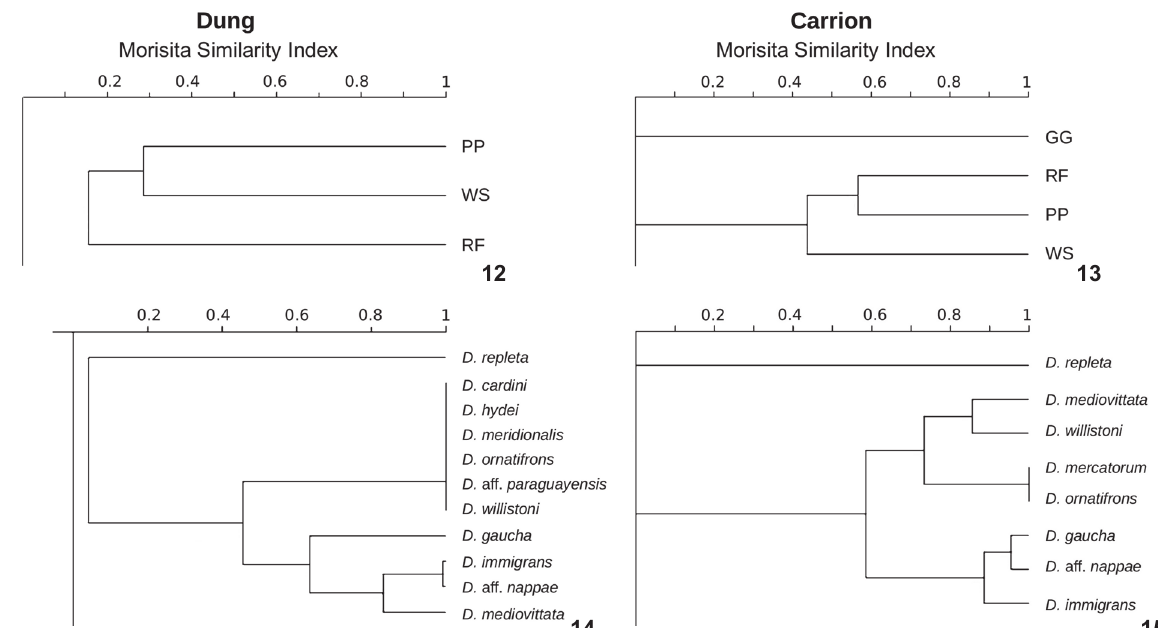
Figures 12-15. UPGMA dendrograms with Morisita’s similarity index representing habitat (upper, 12 and 13) and Drosophila species association (lower, 14 and 15) attracted to dung and carrion baited pitfall